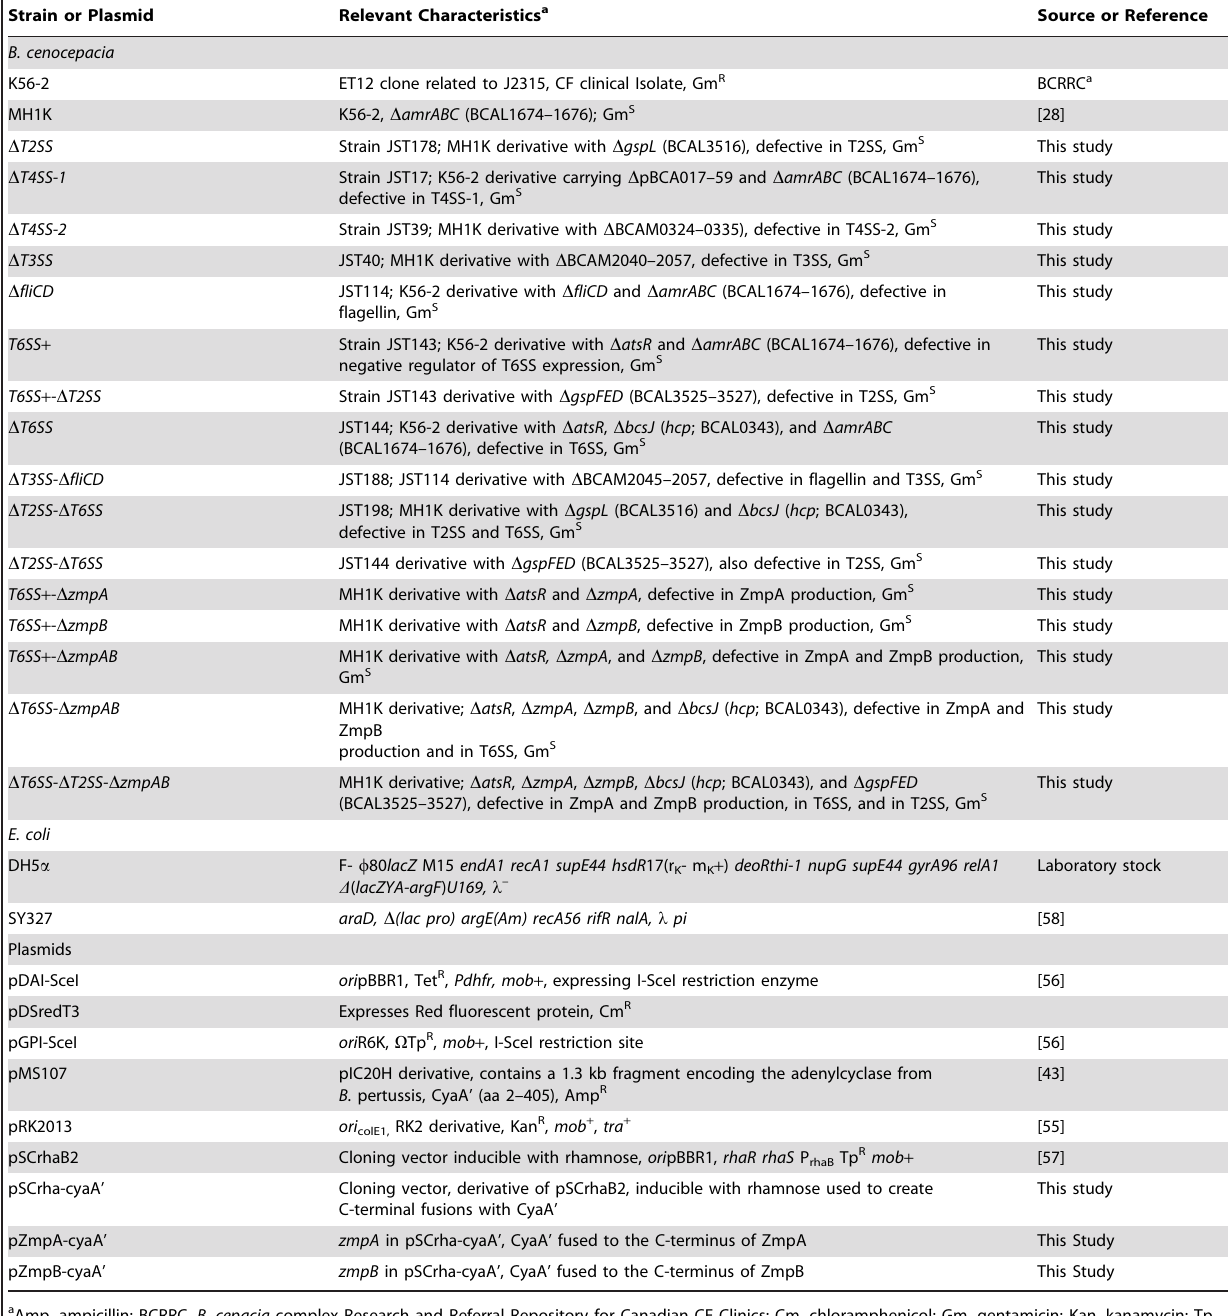
Table 1. Bacterial strains and plasmids used in this